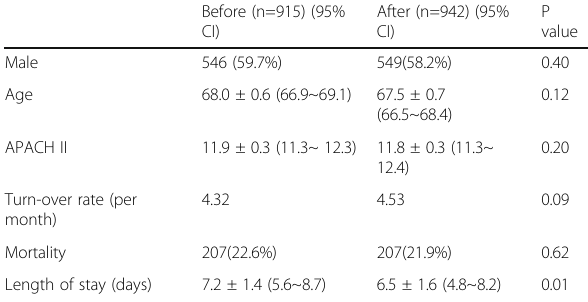
Table 1 (abstract 0036). Effect before and after e-ICU implantation